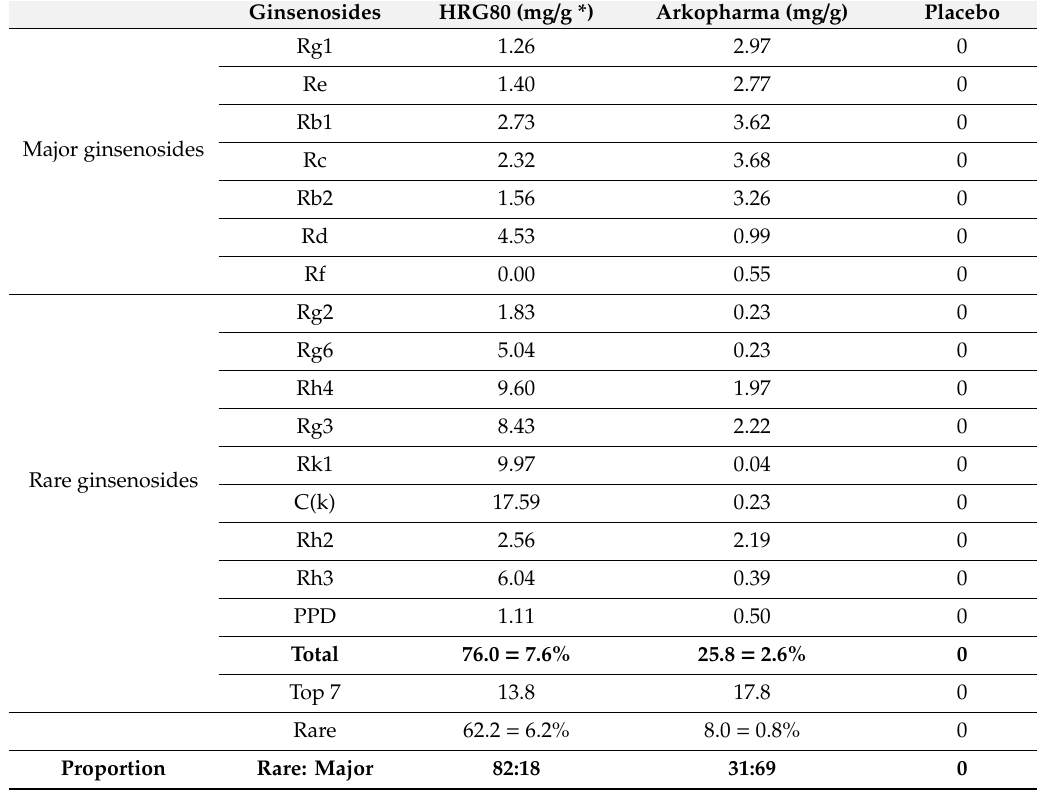
Table 2. Ginsenoside content (mg / g) in HRG80, Arkopharma, and placebo capsule powders. Ginsenosides HRG80 (mg / g *) Arkopharma (mg / g) Placebo